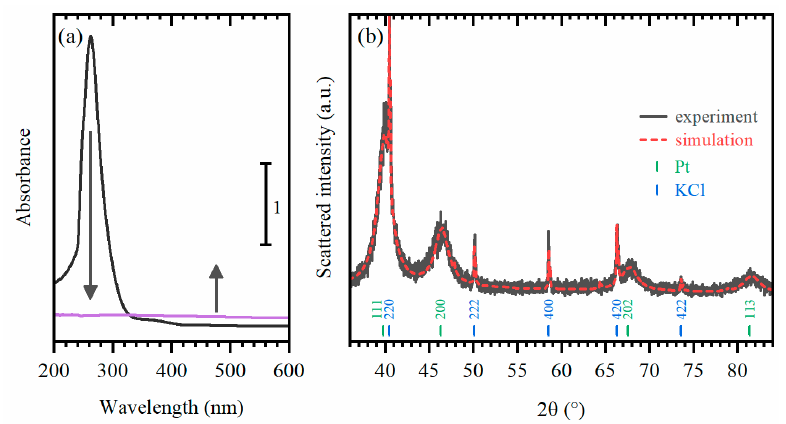
Figure 4. ( a ) UV–Vis spectra of K 2 PtCl 6 in the solution of water and formic acid (3:1) without TiO 2 before (black) and after 1 h of UV irradiation (purple). ( b ) Experimental (solid black) and simulated (dashed pattern) intensities of the dried sample after UV irradiation.